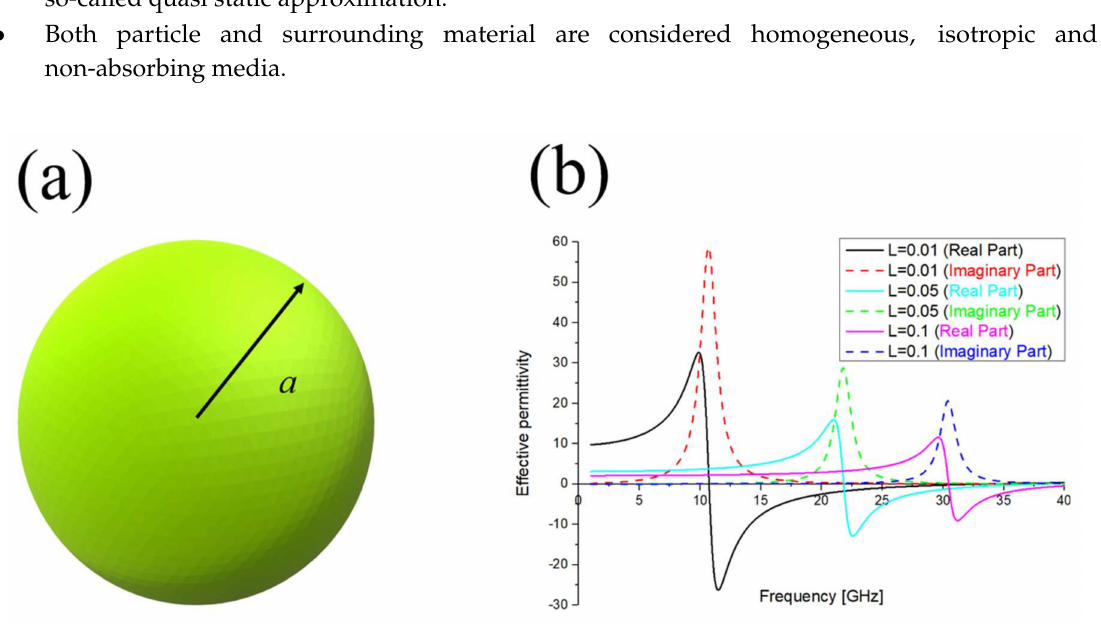
Figure 1. ( a ) Examples of spherical nanoparticle; ( b ) Variation of a generic nanoparticle dielectric permittivity (real and imaginary part) as a function of its depolarization factor L